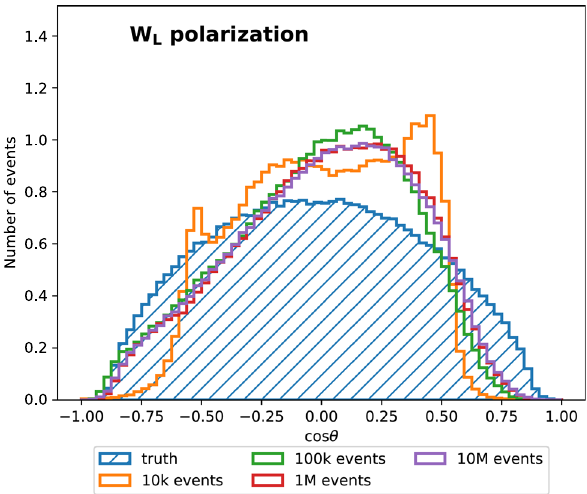
Fig. 14 Reconstructed lepton angular distribution in the semi-leptonic channel, for the longitudinal W boson polarization, as a function of cos ϑ with a specific network topology (60 neurons, 4 hidden layers) for model trained with different training dataset sizes (10 4 , 10 5 , 10 6 , 10 7 events).Parton-level(truth)distributionsareshownforcomparison,